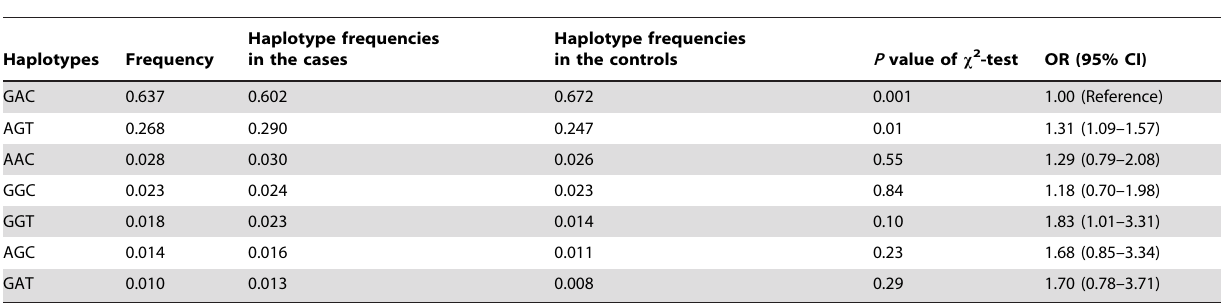
Table 4. Association of TCF2 rs752010-rs4430796-rs7501939 haplotypes with type 2 diabetes.